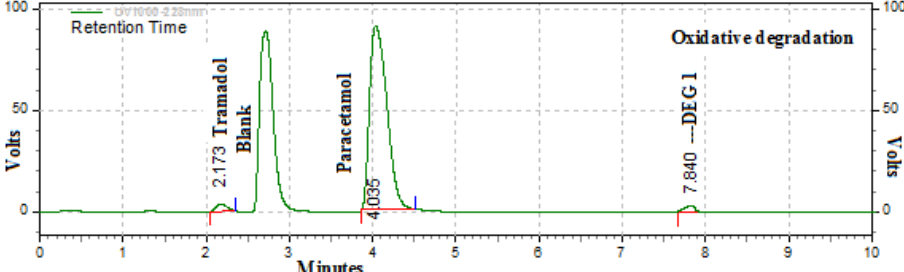
Figure 5. Representative chromatogram obtained from oxidative degradation (3% H